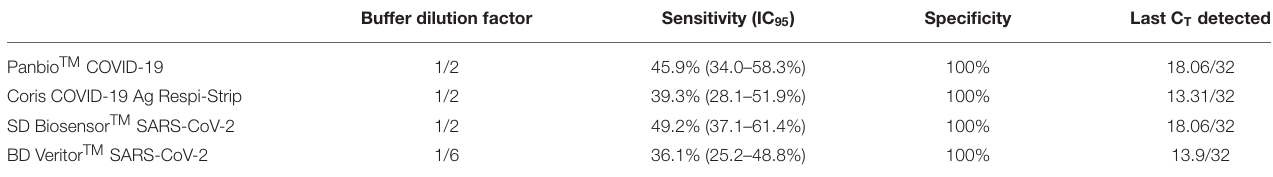
Buffer dilution factor Sensitivity (IC 95 ) Specificity Last C T detected Panbio TM